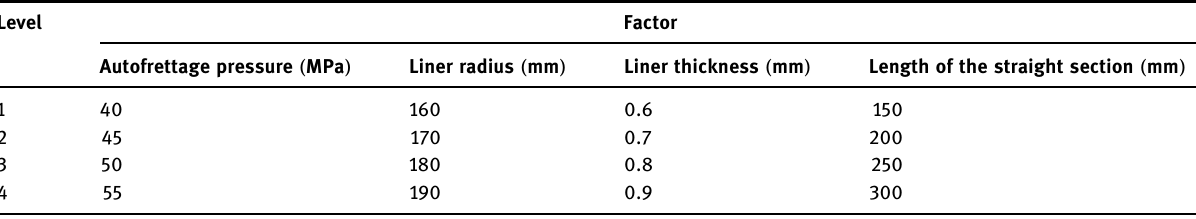
Table 3: Table of factor level